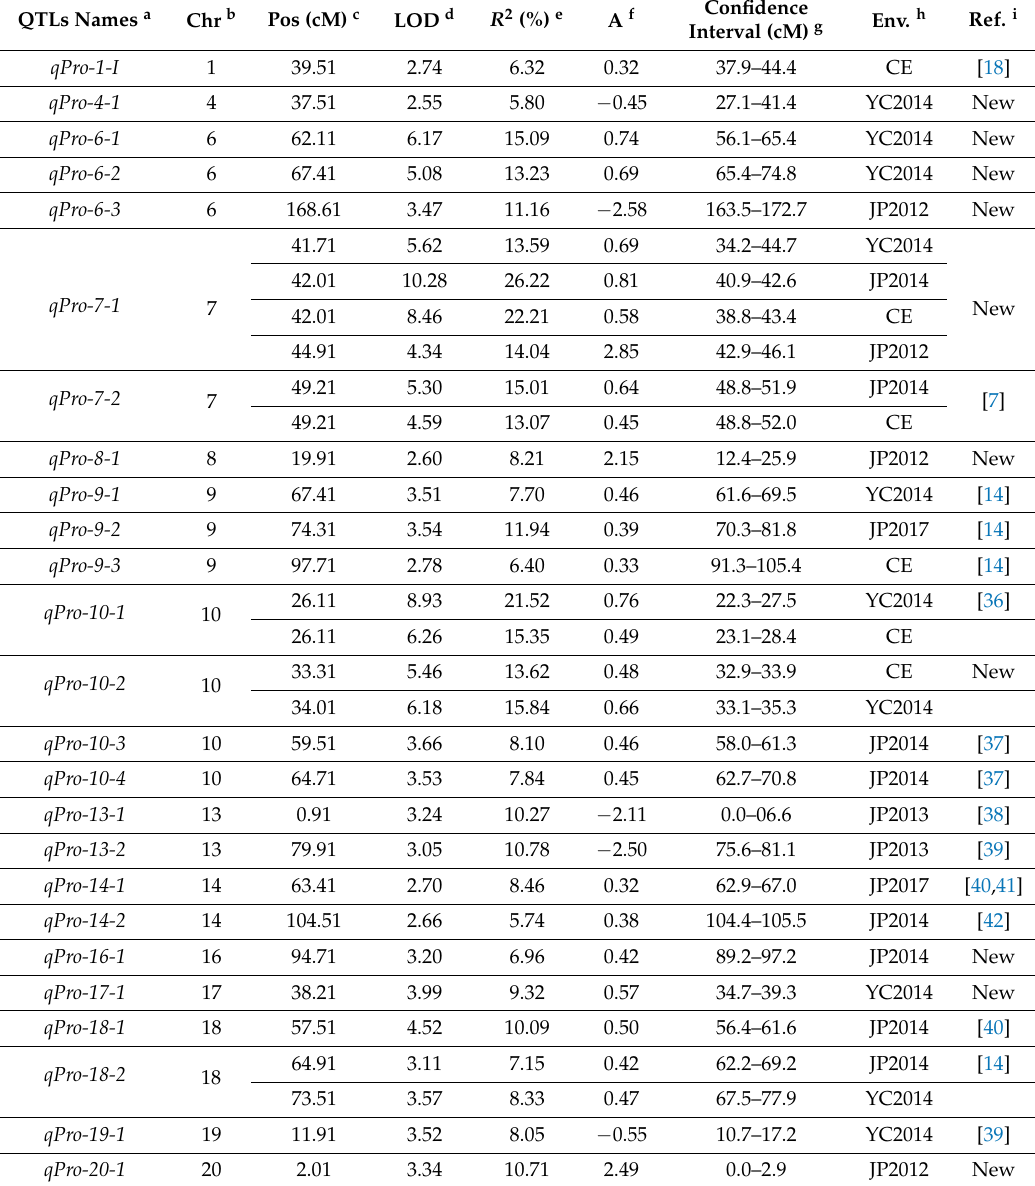
Table 1. Main-effect QTLs identified for seed protein content in the LM6 RIL population across the six environments and combined